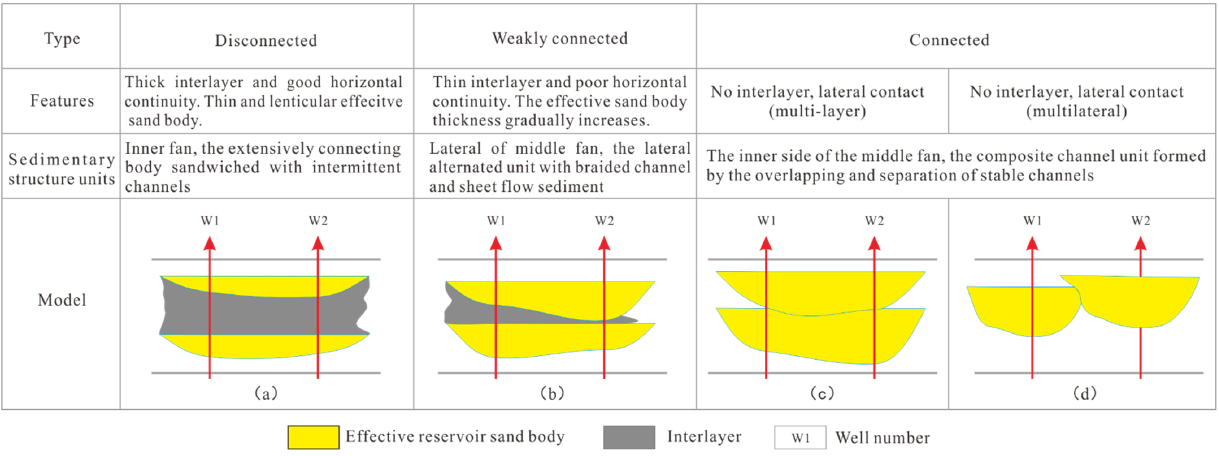
Figure 8. Sand body connecting type of the Qie12 block: ( a ) disconnected; ( b ) weakly connected; ( c ) connected multilayer; ( d ) connected multilateral.